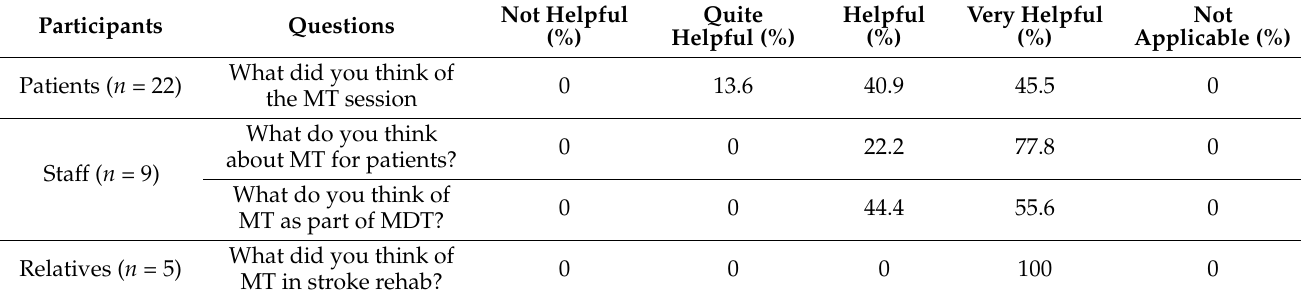
Table 2. Responses to the question ‘What do you think of music therapy?’.